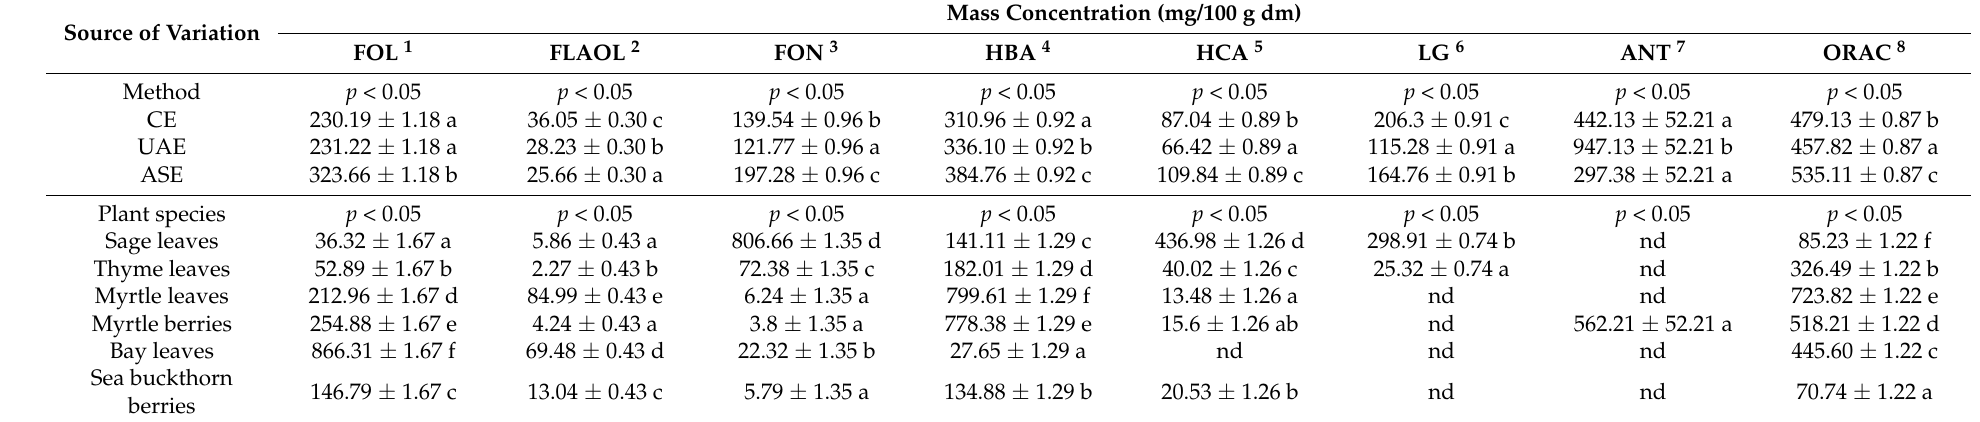
Table 3. The influence of applied extraction method and plant species on the mass concentration of polyphenols and antioxidant capacity of obtained